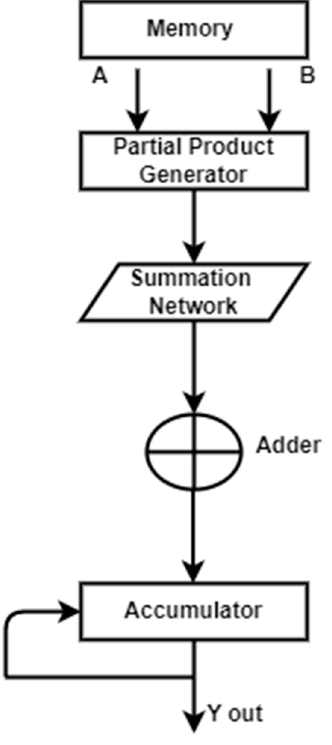
Figure 6. The general structure of MAC.